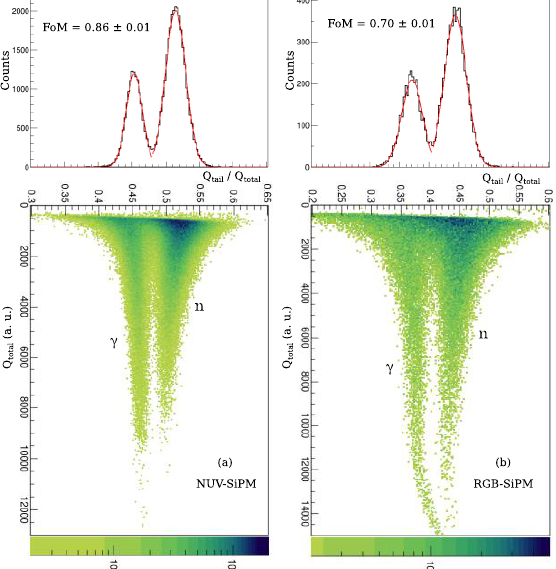
Fig. 8. 2D plots, PSP versus Q total , corresponding to the measurements using the Am-Be source with the EJ-276G (25 mm dia. x 25 mm thick.) coupled to the NUV-SiPM (a) and to the RGB-SiPM array (b). PSP distributions and FoM values (at ~1 MeVee) are reported on top. C. EJ-299, 50 mm dia. x 50 mm thick.